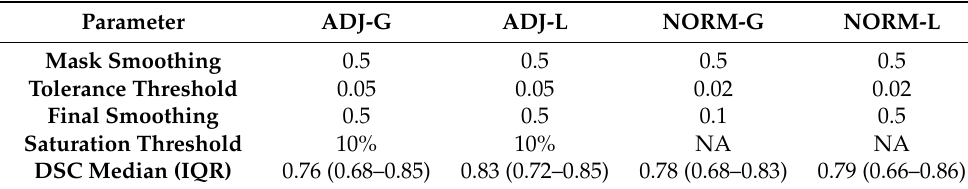
Figure 4. DSC changes using different parameter values. Each boxplot shows the DSC of all the pipelines where one parameter was set to a certain value. Significant increases and decreases are indicated with a star and a triangle. Boxbplots corresponding to the optimal values are in green. Top edges of the boxes indicate the 25th and 75th percentiles. Table 2. Optimal parameter values and their associated DSC.